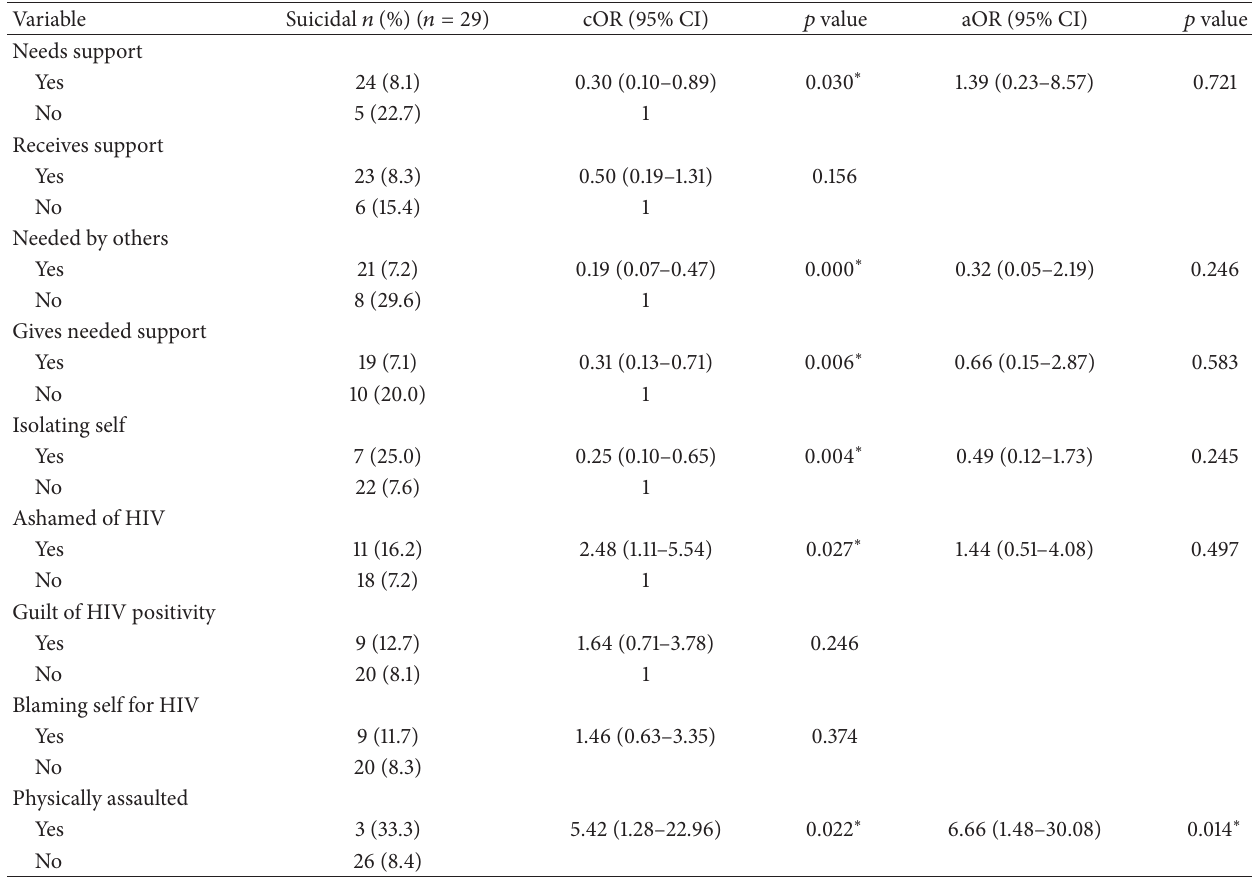
July–October 2009 ( 𝑁 = 317